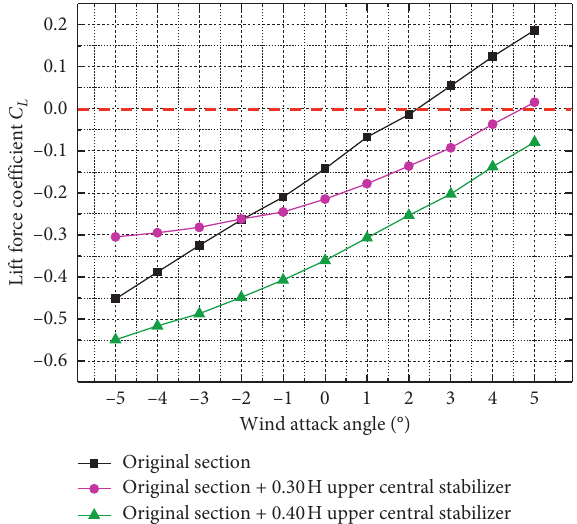
Figure 5: Lift force coefficients for different wind attack angles.